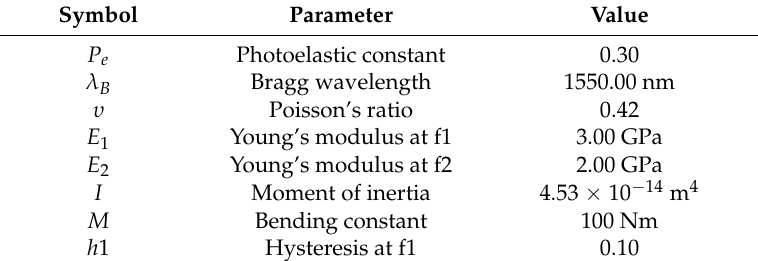
Table 1. Parameters employed in the sensor simulation.